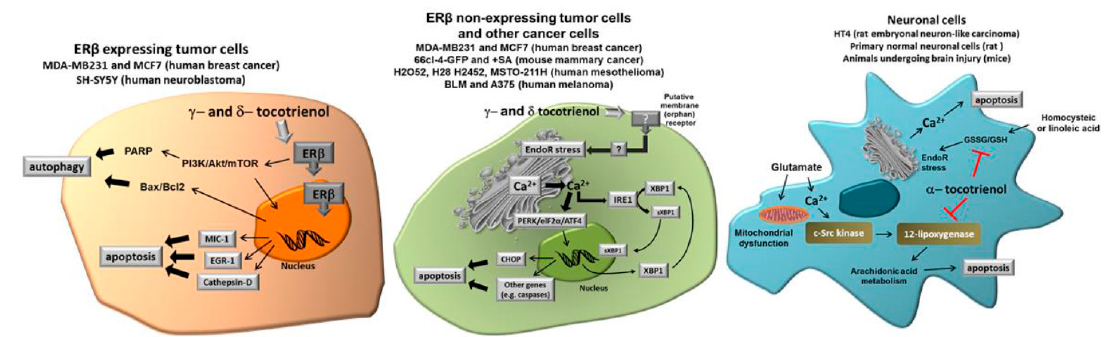
Figure 2. Different molecular targets of tocotrienols in the representative cell types we have considered in this review, namely cancer cells expressing Estrogen Receptor (ER), cancer cells not expressing ER and normal neuronal cells submitted to specific stressors such as glutamate or homocysteic acid. See text for more details. (Modified from [31]).